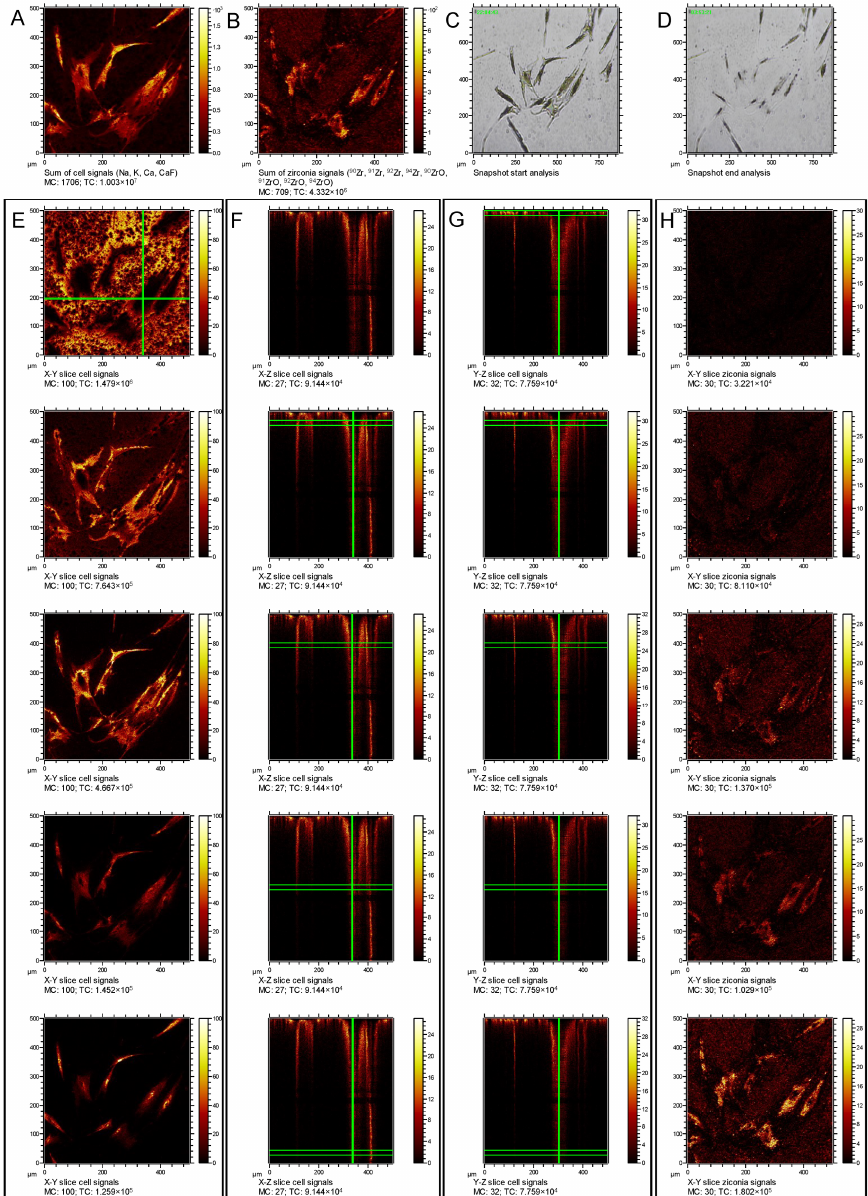
Figure 3. Depth integrated combined signals from cellular components ( A ) and ZrNP ( B ), optical micrographs before ( C , D ) after erosion. Cross sectional cellular ( E – G ) and zirconia ( H ) signals. First row ( E , H ), show the signals at the beginning of the erosion. ( E ) X–Y slice of cellular signals; X–Z ( F ) and Y–Z ( G ) slices cut thereof at the green lines displayed in the images. ( H ) X–Y slice of zirconia signals at the beginning of the erosion as indicated by green lines in this column. The following rows are again showing the same signals with gradually deeper layers for the cellular signals and zirconia